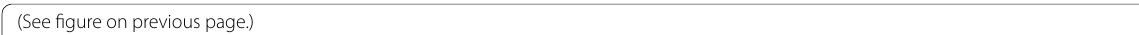
figure on previous Fig. 2 Immunological analyses of CYP19A1–ESR axis in breast cancer. a – c Spearman correlations between CYP19A1, ESR1, ESR2 and multiple TILs across human cancers. For each cancer type, the relative abundance of TILs were inferred by using GSVA based on gene expression profile (TCGA). The readouts of BRCA were highlighted in black frames. d – g Spearman correlations between CYP19A1 and representative immunostimulators (including IL6, TNFRSF8, C10orf54 and CD48) in BRCA (TCGA). h – k Spearman correlations between ESR1 and representative immunostimulators (including IL2RA, TNFRSF8, ULBP1 and CD40) in BRCA (TCGA). l – o Spearman correlations between ESR2 and representative immunostimulators (including TNFRSF13C, TNFRSF17, CD27 and TNFRSF13B) in BRCA (TCGA). The detailed rho and p-value were individually shown as indicated in each panel, and p-value < 0.05 was considered statistically